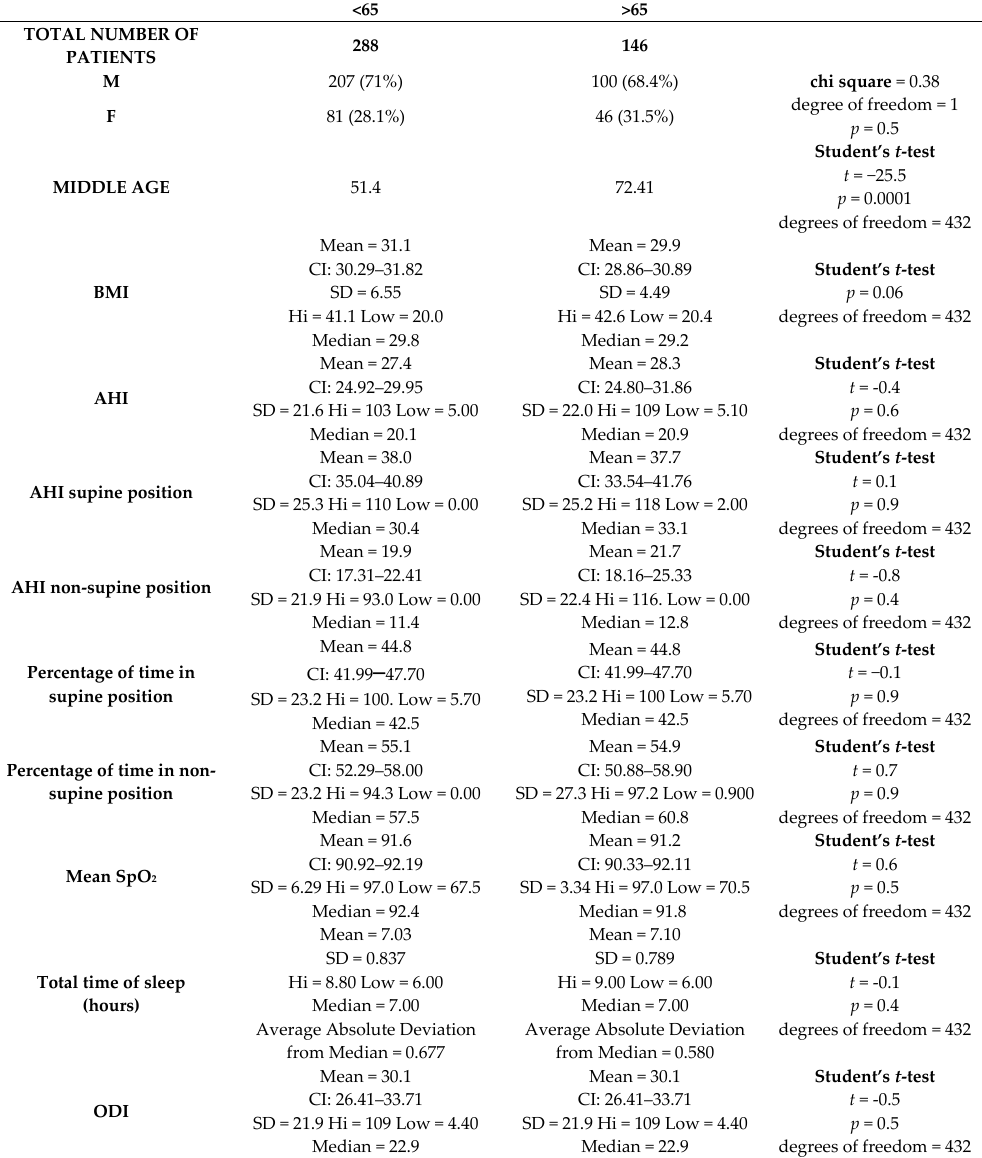
Table 1. Patient’s characteristics and polysomnographic data.